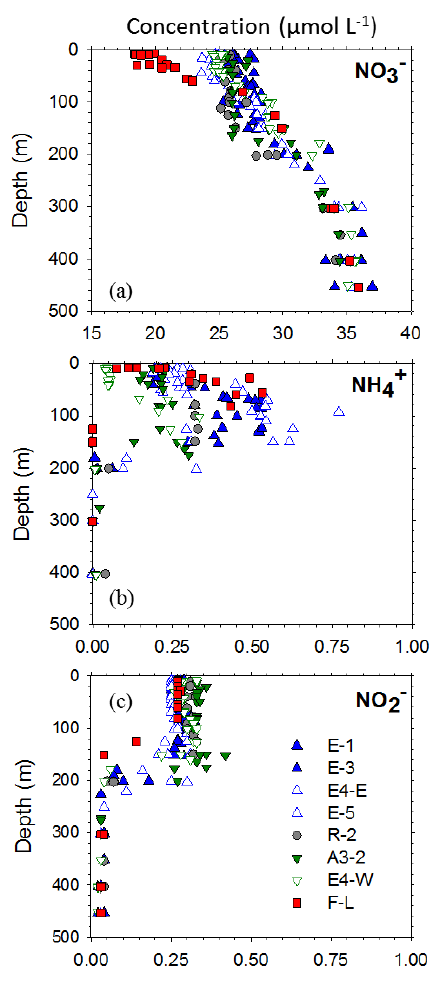
Figure 2. Nitrate (a) , ammonium (b) , and nitrite (c) concentration (µmolL − 1 ) vs. depth (m). See Supplement for detailed [NH + tical profiles and associated MLD per station.